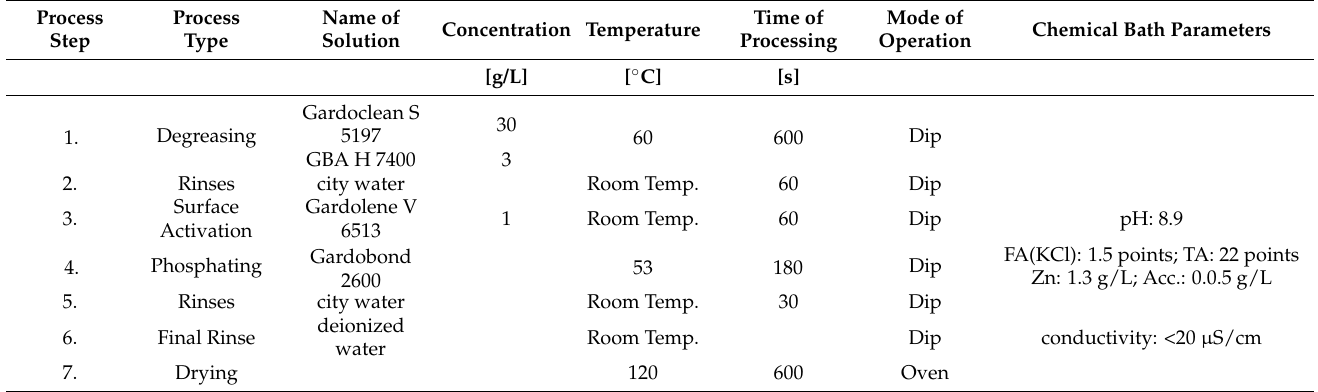
Table A1. Process parameters of zinc phosphating with nitroguanidine accelerator.